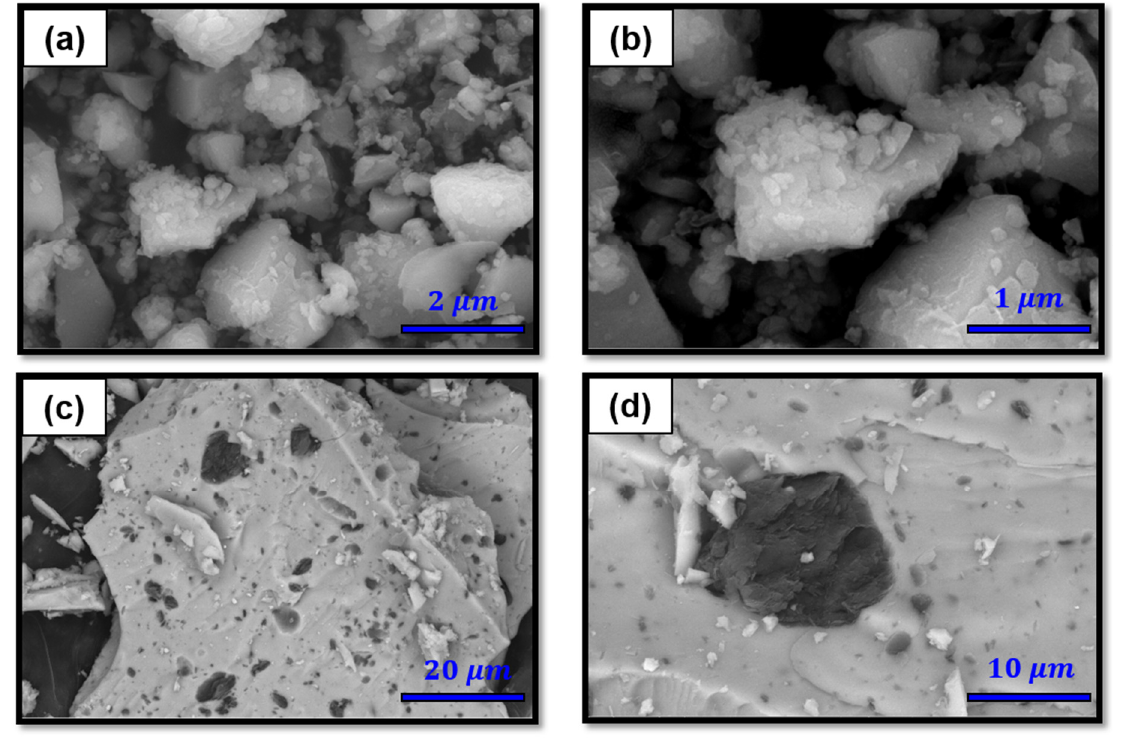
Figure 1. SEM images of Zr(OH) 4 ( a ) in low and ( b ) in high magnification and Zr(OH) 4 / GO nanocomposite ( c ) in low and ( d ) in high magnification. Images of Zr(OH) 4 / GO nanocomposite were taken in the backscatter mode to distinguish GO from Zr(OH) 4 .